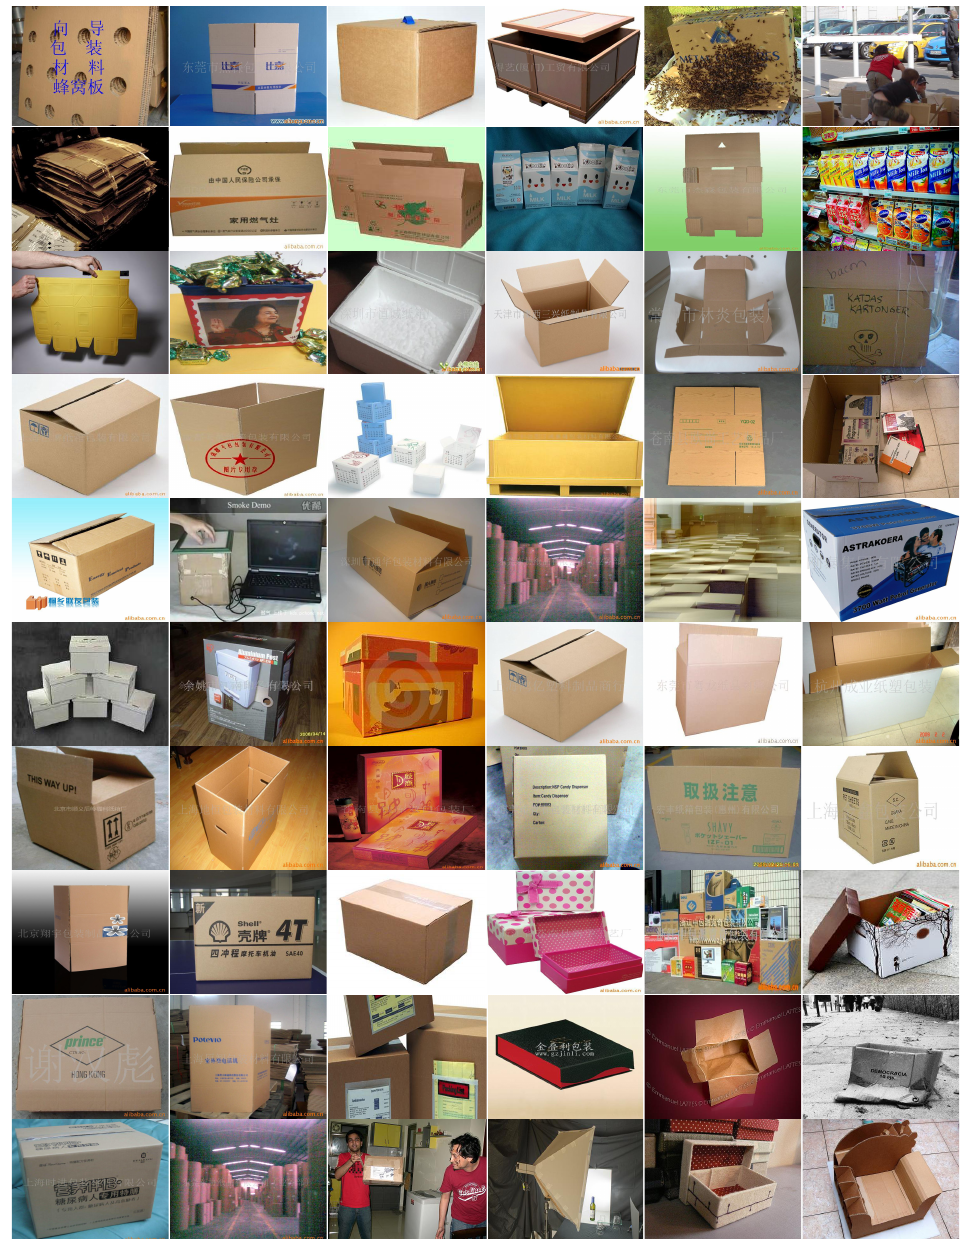
Figure A1. Randomly sampled images related to cartons on ImageNet